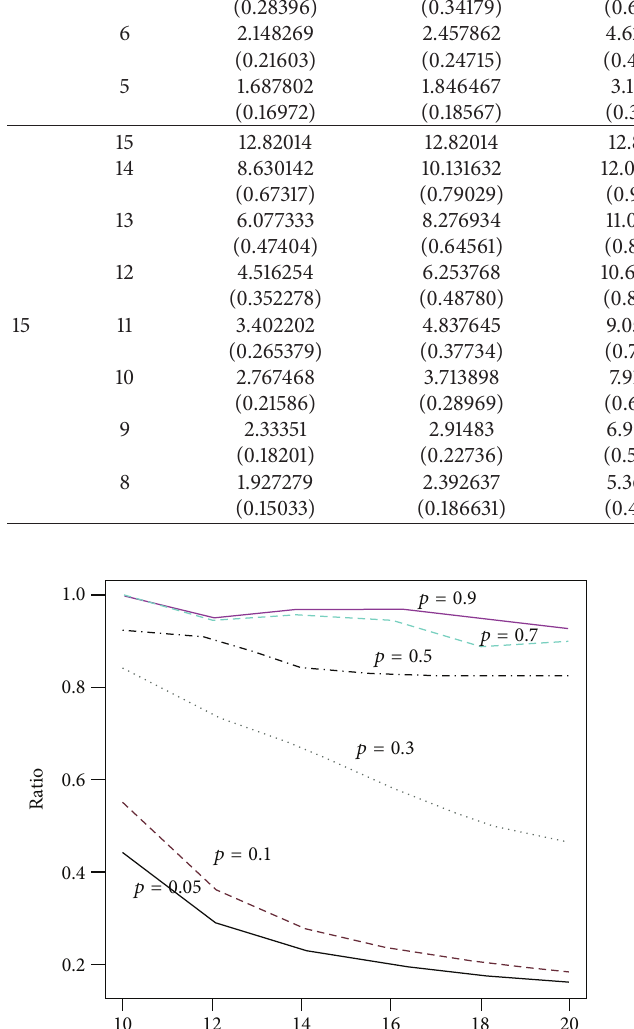
under complete sample. REET